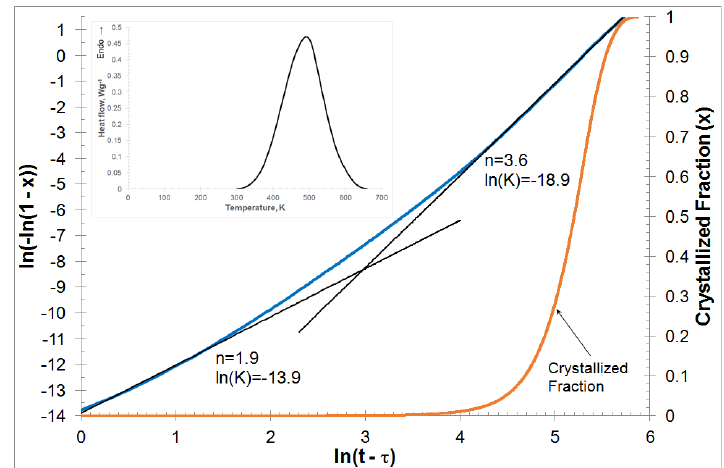
Figure 1. Isothermal differential scanning calorimeter (DSC) curve traces at annealing temperature equal to 507 K and the Kolmogorov-Johnsona-Mehla-Avrami-Evans plot and crystallized fraction for the isothermal crystallization process of Mg 72 Zn 24 Ca 4 ribbon at annealing temperatures equal to 507 K, data obtained at temperatures above T g as indicated. The values of n and ln( K ) are also shown for two regions: early and late stages of crystallization.